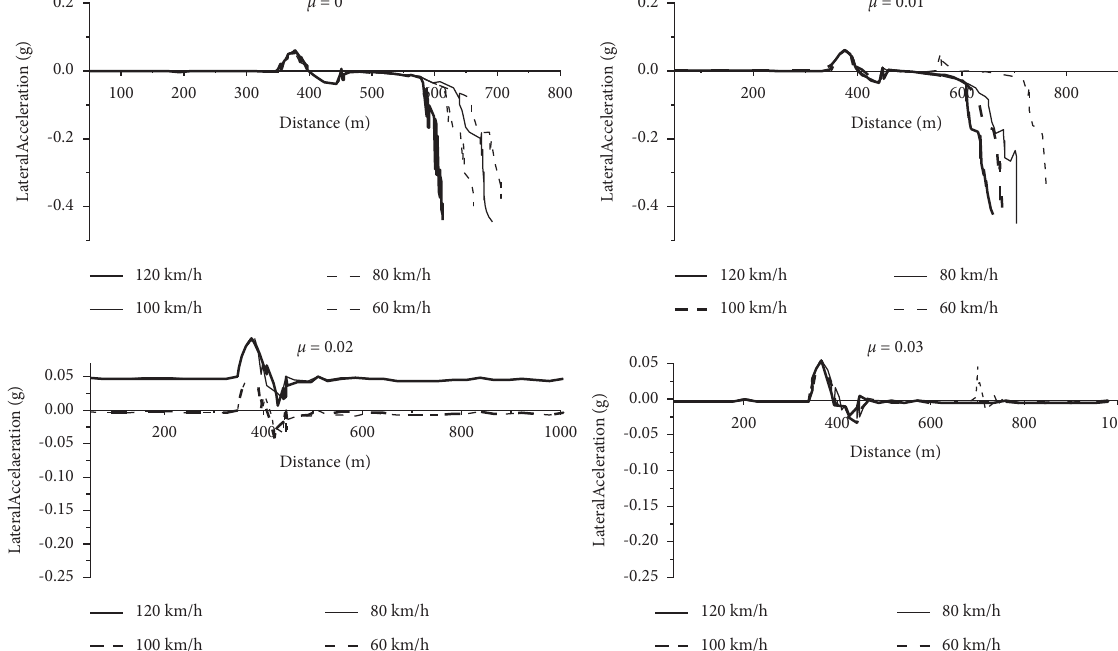
� − 0 . 4 g ) . (a) µ � 0, (b) µ � 0.01, (c) µ � 0.02, and (d) µ � 0.03. m